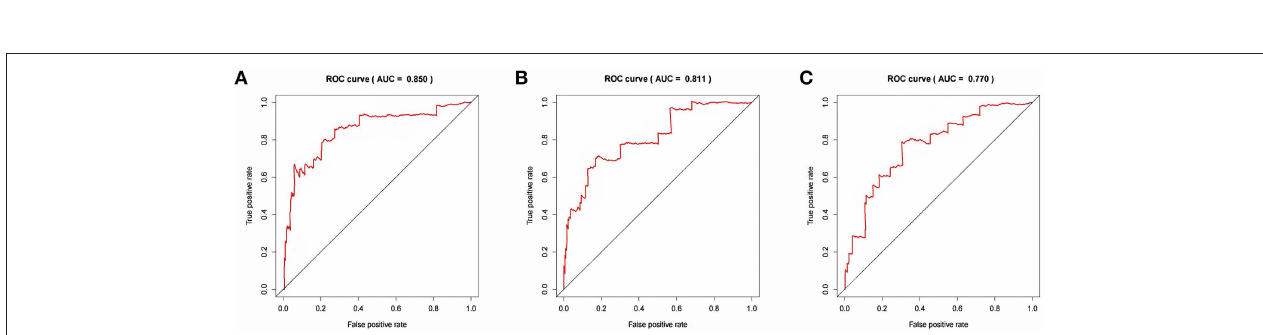
FIGURE 6 | The receiver operating characteristic curve analysis of the risk score in predicting the overall survival curves of colon cancer patients: (A) the lncRNA-based model, (B) the miRNA-based model, and (C) the mRNA-based model.